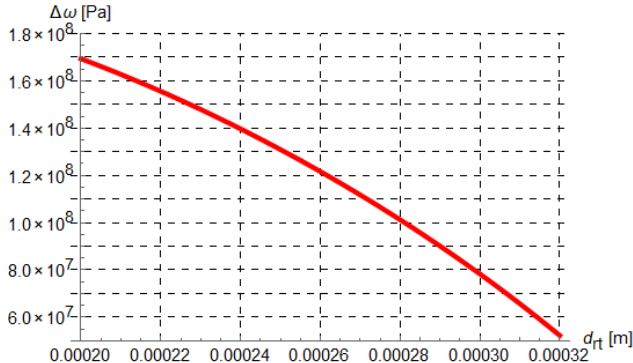
Figure 9. The course of absolute pressure loss ∆ ω , as a function of hole diameter d rt .